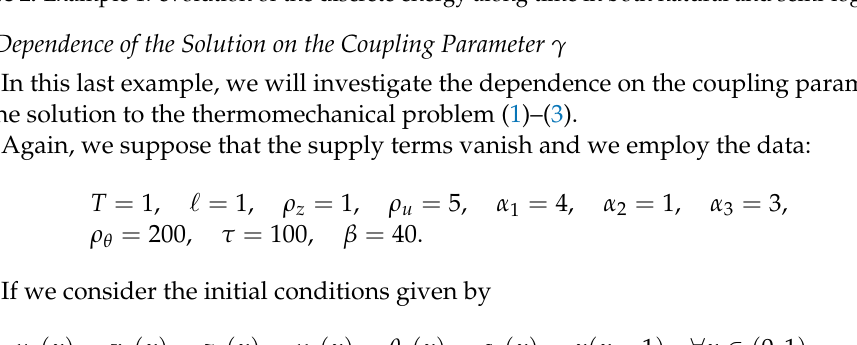
Figure 2. Example 1: evolution of the discrete energy along time in both natural and semi-log scales.